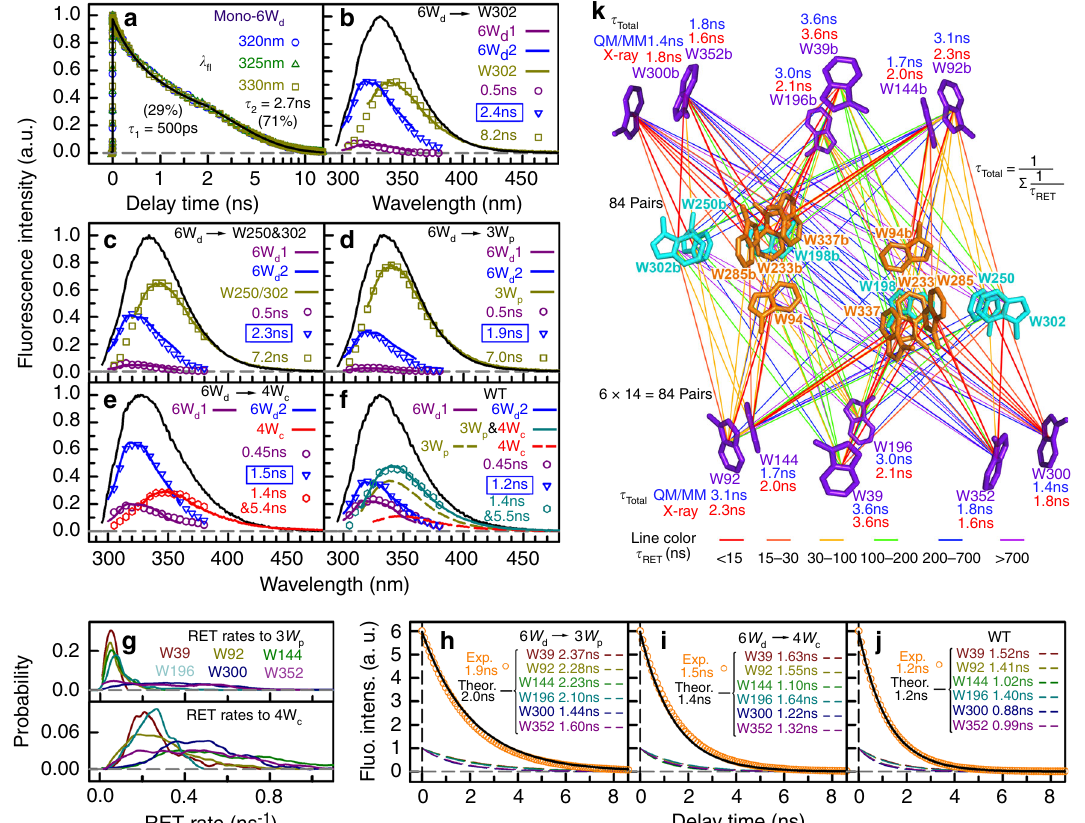
Fig. 2 Excitation-energy transfer from W d to W p and W c in UVR8. a Fluorescence transients for mono-6W d gated at 320, 325, and 330 nm. Note the log scale starting from 2 ns. The lifetimes of W d were determined to be τ 1 = 0.5 ns (29%) and τ 2 = 2.7 ns (71%). b – f Timescales from a global fi tting and lifetime-associated spectra of selected 6W d + 1W p ( b ), 6W d + 2W p ( c ), 6W d + 3W p ( d ), 6W d + 4W c ( e ), and WT ( f ). Fluorescence transients are shown in Supplementary Fig. 1. For each panel, the solid lines are the steady-state emission spectra of various mutants. The lifetime-associated spectra are shown in various symbols and the directly measured spectra are shown in lines. The time constant corresponding to the original 2.7-ns component is highlighted in a box. 6W d 1 and 6W d 2 are the emission spectra of the two W d lifetimes decomposed as described in Methods. Note that the total spectrum of 1.4 and 5.4 ns shown for 6W d + 4W c agrees with the 4W c emission. The total spectrum of 1.4 and 5.5 ns shown for WT can be decomposed into 3W p and 4W c emission (dashed lines). g Energy-transfer rate distributions for each W d to 3W p (top) and to 4W c (bottom) based on QM/MM methods. h – j Simulations of the original 2.7-ns component decay dynamics of 6W d for 6W d + 3W p ( h ), 6W d + 4W c ( i ), and WT ( j ) based on RET rate distributions. For each case, the overall 6W d decay curve (black line), the sum of six individual W d decay curves (dashed lines), can be fi tted with a single-exponential decay and agrees well with the experimental decay dynamics shown in ( d – f ). k The 168 possible energy-transfer pathways (based on QM/MM) from all W d to 14 interfacial W residues (3W p + 4W c on both subunits). The total RET time constants based on QM/MM (blue) and on X-ray structure (red) are shown near each W d . Each line represents one energy-transfer pathway. Colors of the lines are based on effective RET time constants. The dominant paths are shown in